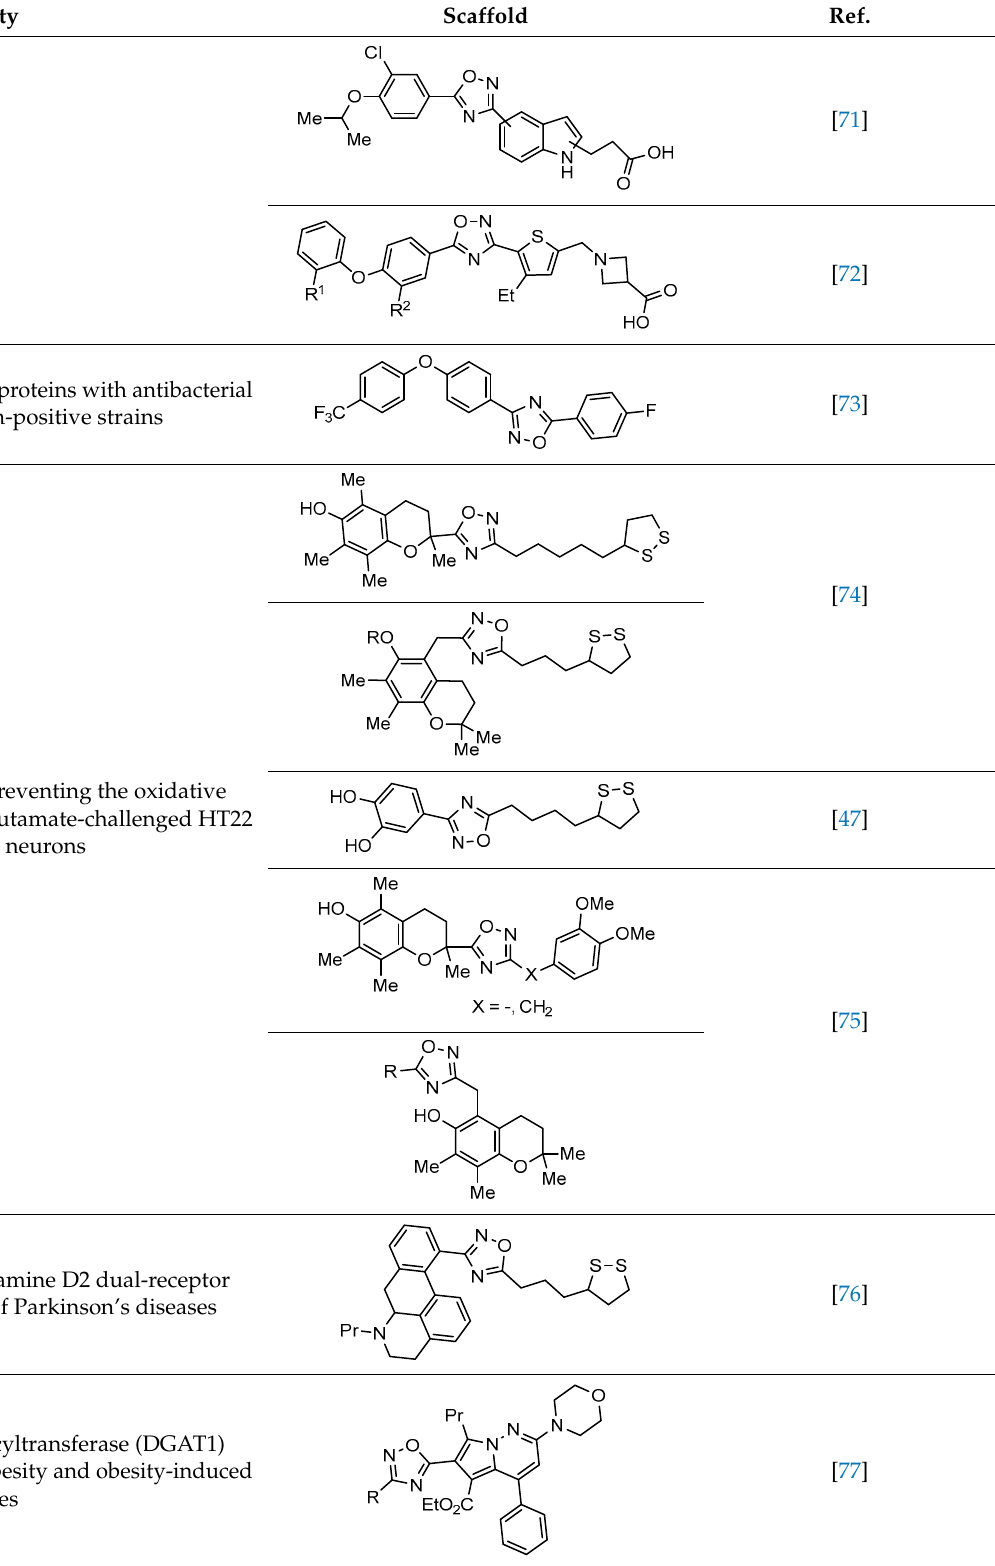
Table 1. Cont. Activity Scaffold